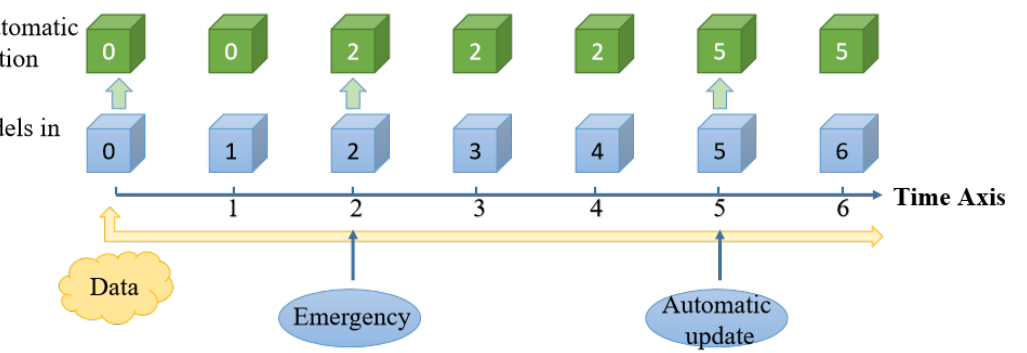
Figure 10. Schematic diagram of an application scheme.